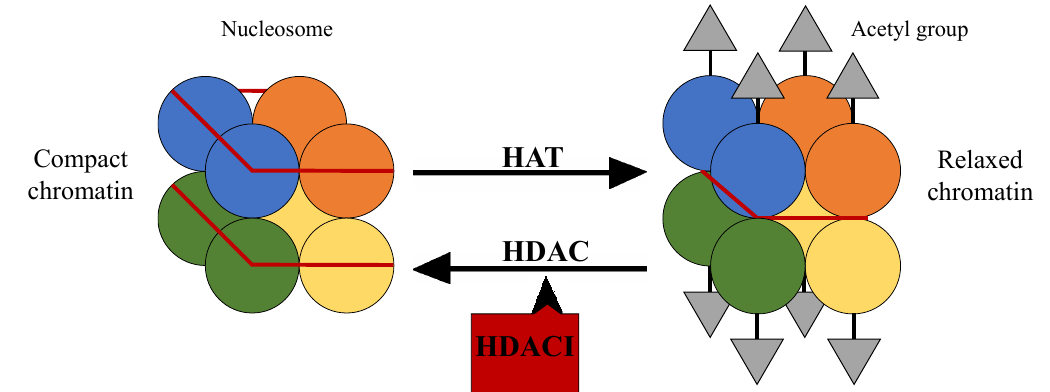
Figure 1. The structure of the nucleosome and the action of histone acetyltransferases and histone deacetylases.